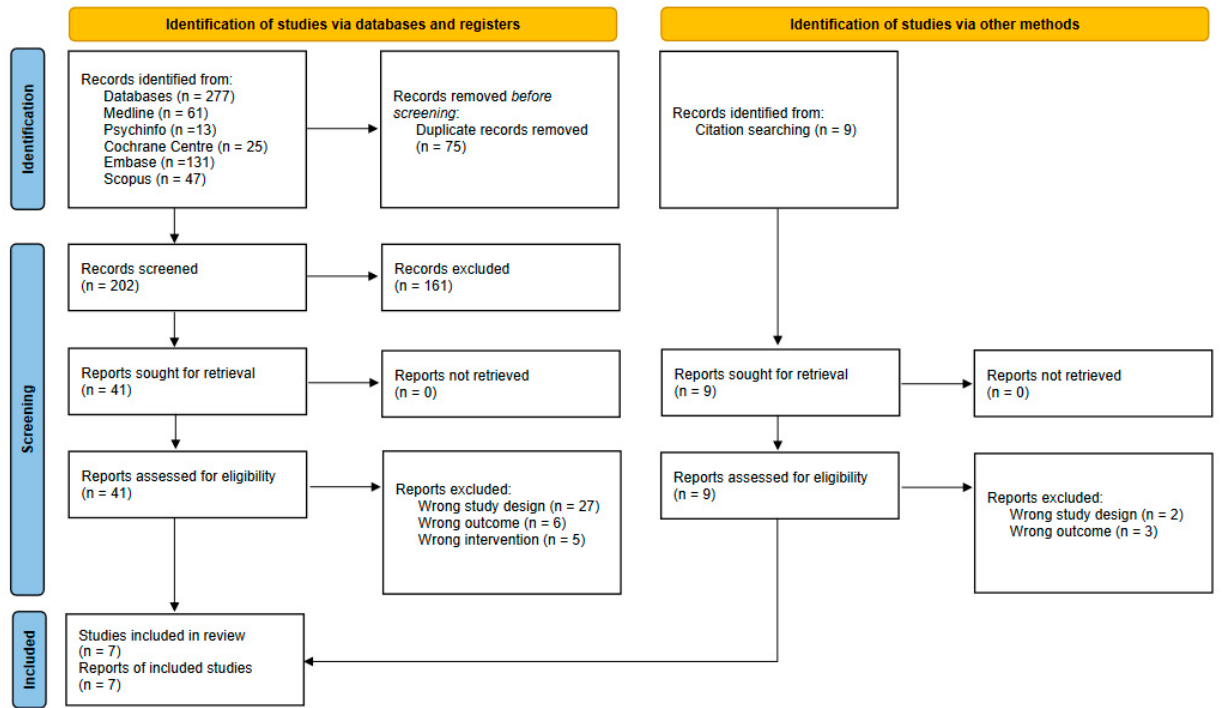
Figure 1. PRISMA flow diagram for searches of databases, registers and other sources for N-of-1 study designs, from [20].